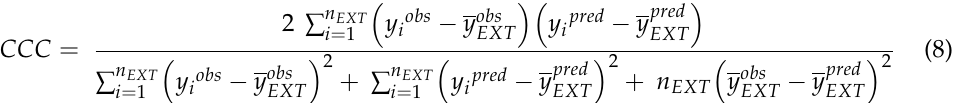
Table S4. The obtained retention times and log kw for the target sulfonamide derivatives in C 8 chro- matography; Table S5. The obtained retention times and log kw for the target sulfonamide derivatives in Cyanopropyl chromatography; Table S6. The obtained retention times and log kw for the target sulfonamide derivatives in phenyl chromatography; Table S7. List of molecular descriptors used to build QSRR models.; Table S8. The values of theoretical descriptors for each compound; Figure S1. William’s plots and y-randomization tests (Q2 vs. R2) generated for each model. The numbers correspond to the next stationary phases A) IAM. B) C18. C) C8. D) CN. E) Ph and F)